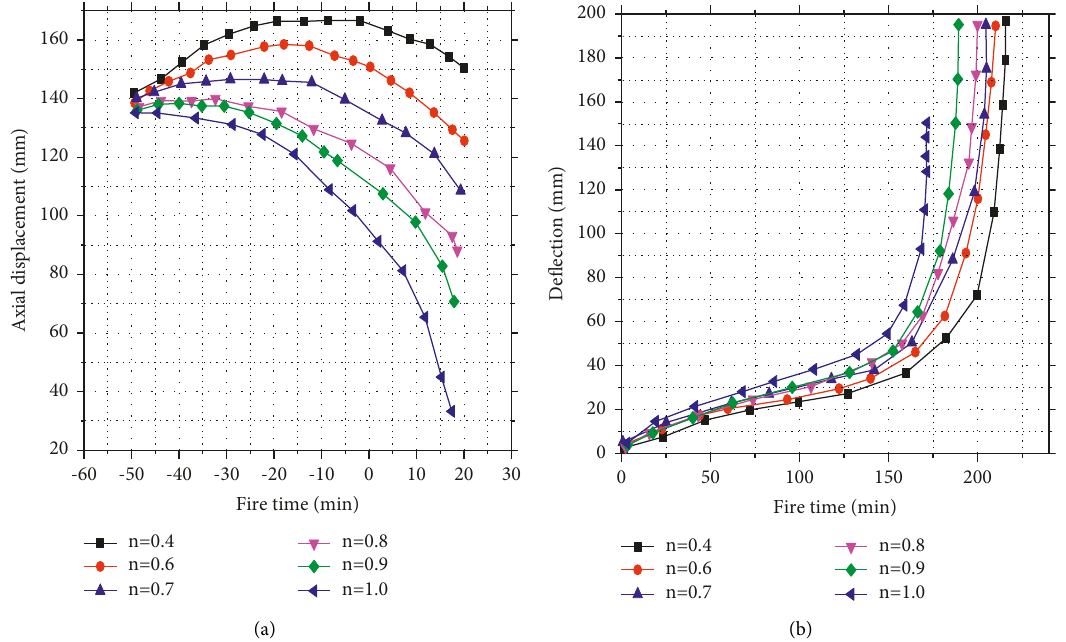
Figure 3: Analysis of axial compression ratio results. (a) Axial displacement analysis diagram of column top in the fire; (b) deflection of side span on